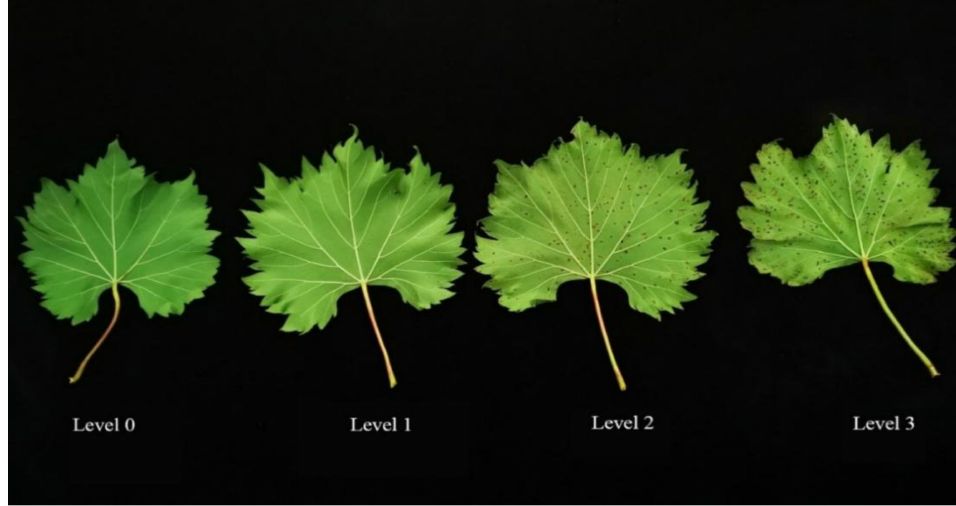
Figure 2. Classification of ozone